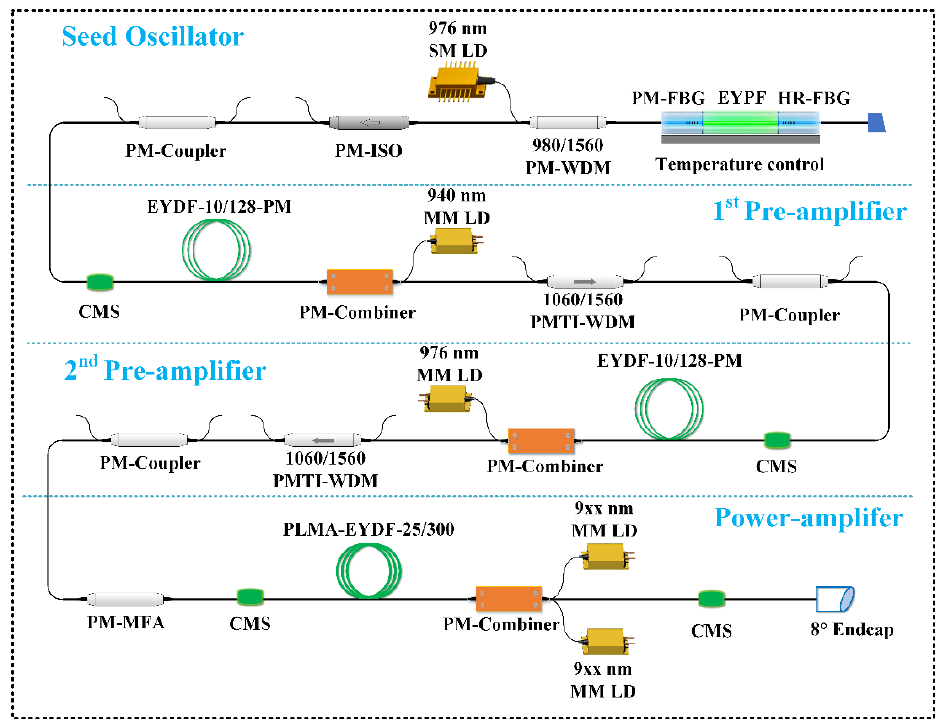
Figure 1. Experimental setup of the 1560 nm high-power linearly-polarized SFFL. (HR-FBG: high-reflected fiber Bragg grating; EYPF: Er–Yb co-doped phosphate fiber; PM: polarization-maintaining; WDM: wavelength division multiplexer; SM: single-mode; LD: laser diode; ISO: isolator; CMS: cladding-mode stripper; EYDF: Er–Yb co-doped double-cladding fiber; MM: multi-mode; TI: tap isolator; MFA: mode field adaptor; PLMA: PM large-mode-area).